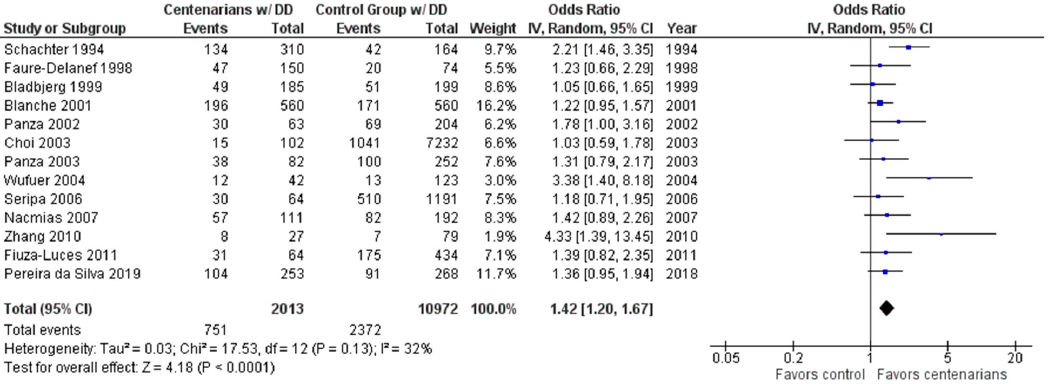
Figure 3. Comparison of ID genotype frequency in centenarians and control groups. The ages of centenarians and control groups are described in Table 1. The p- value is indicated by P in the Figure. As shown in Figure 4, the association between the II genotype and exceptional lon- gevity was analyzed in 13 studies [20,22,25–35]. The II genotype was found to have an OR of 0.81 (95% CI: 0.66–0.98, p = 0.03) with mild heterogeneity (28%), indicating a significant negative association between the II genotype and longevity.